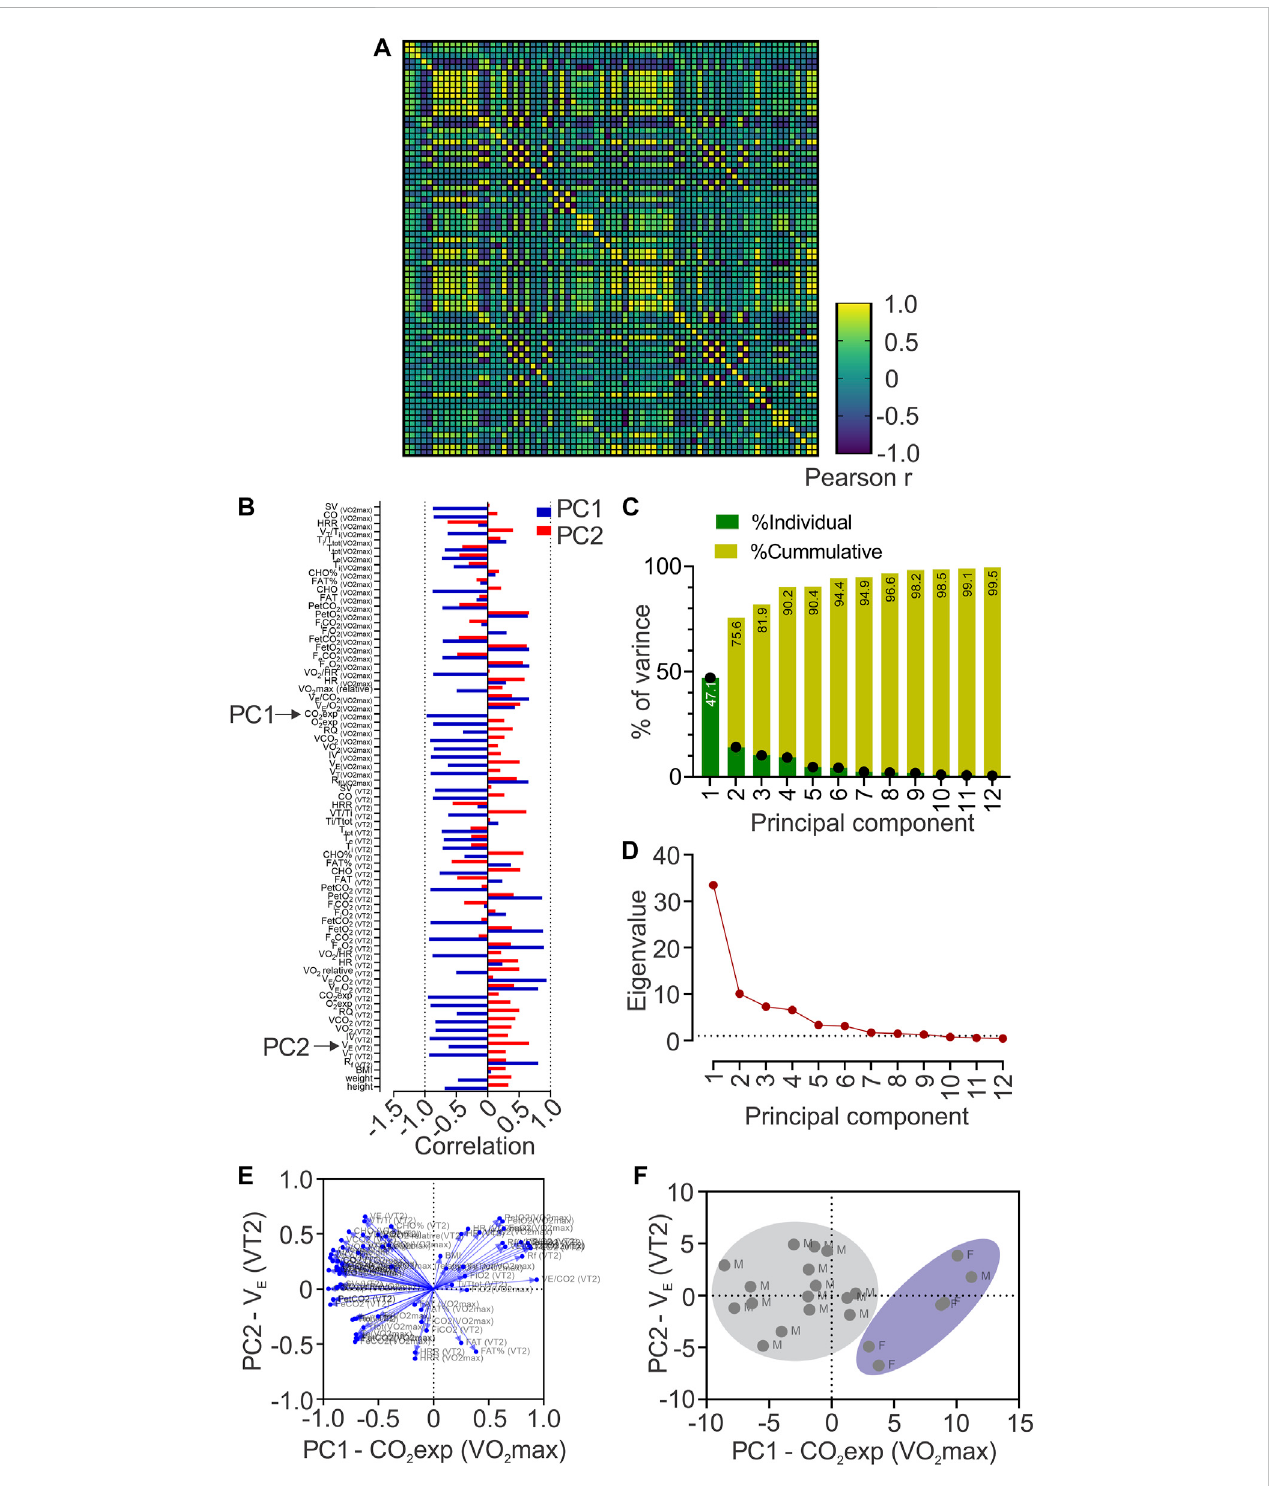
FIGURE 2 Principal components analysis (PCA). (A) , Heatmap of Pearson correlation coef fi cients between all data sets showing Pearson r values; (B) , Loadings of each to PC1 and PC2; (C) , Contribution of each Principal Component (PC) to the total variance of data; (D) Principal component analysis showing